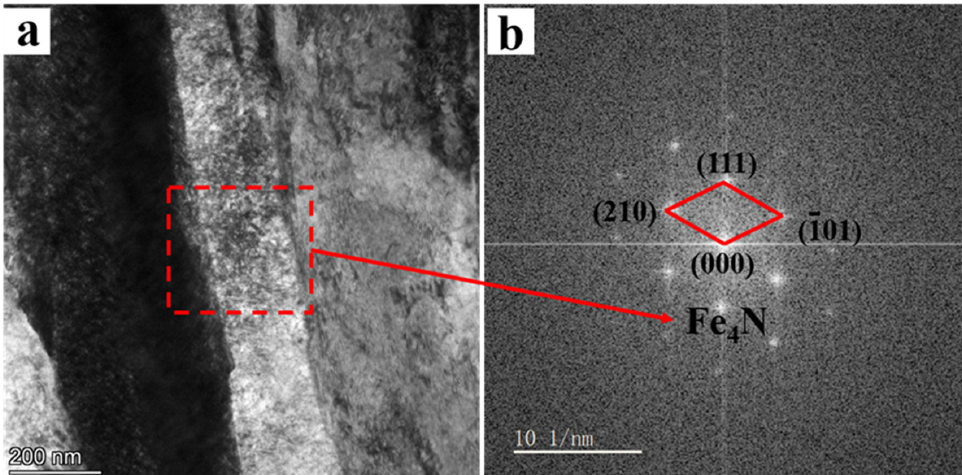
Figure 9. ( a ) TEM image of the N-state diffusion layer; ( b ) selected area electron diffraction pattern (SAEDP) corresponding to ( a ).